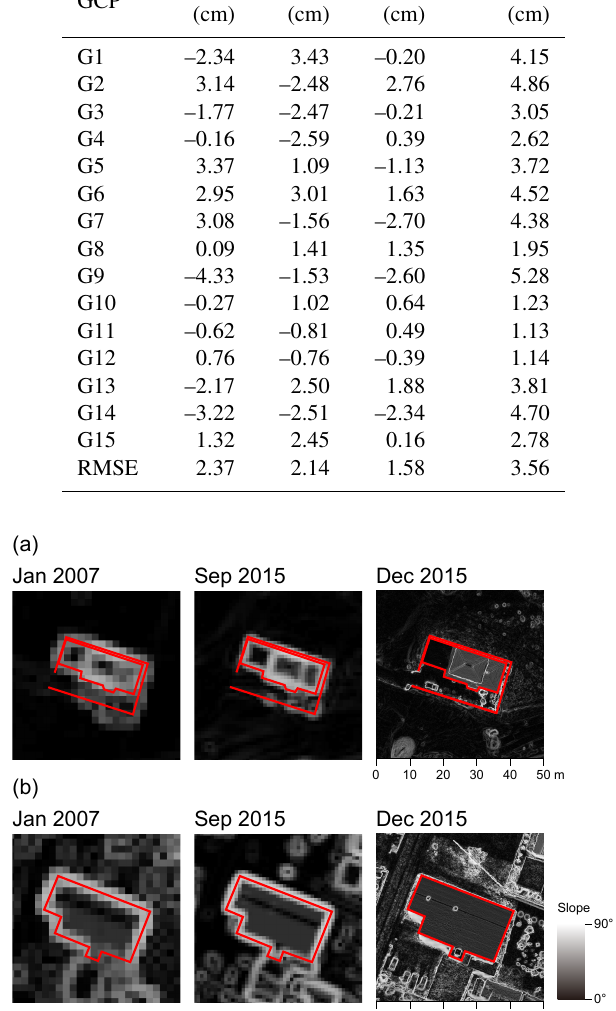
Figure 4. Gradient maps showing two buildings used to evaluate the horizontal accuracy of the DSMs. The cell sizes are the same as in the originals. Red lines indicate the edges of buildings or walls on the December 2015 map. Note that these lines are within high- slope-gradient areas on the maps for the other two dates. See Fig. 3a for the locations.